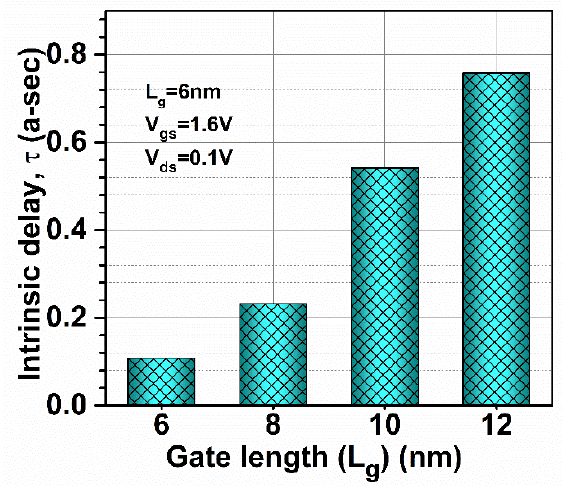
Figure 13. Intrinsic delay at various gate lengths of GaN-SOI-FinFET.